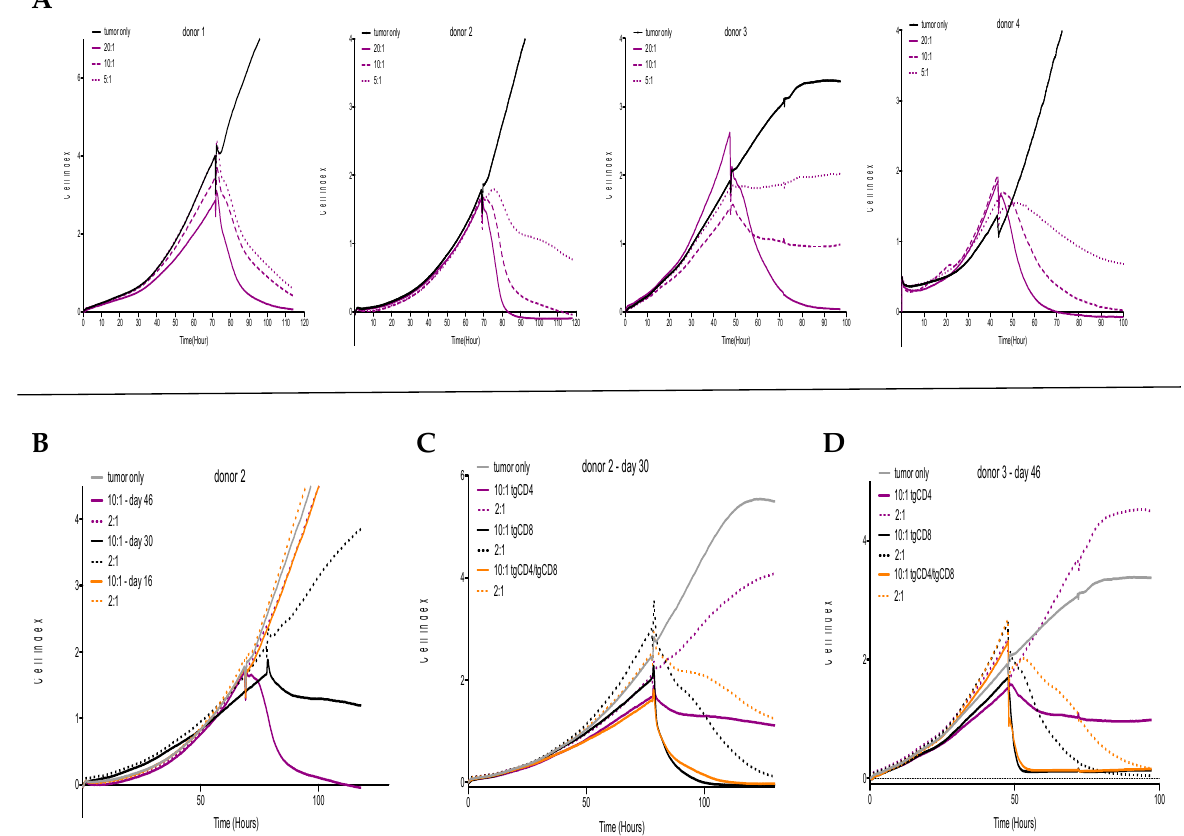
Figure 2. Donor- and time-dependent antitumor activity of STEAP1 130 / HLA-A*02:01-specific TCR transgenic CD4 + (tgCD4) T cells and CD8 + (tgCD8) T cells in vitro. ( A ) STEAP1 130 tgCD4 T cells show donor-dependent antitumor activity after 6 weeks of expansion and culture against A673 cells (4 donors). ( B ) Antitumor activity of tgCD4 T cells increased with the number of days in cell culture; assessed at day 16, 30, and 46 in effector-to-target ratios (E:T) 10:1 and 2:1. ( C,D ) Evaluation of antitumor activity of tgCD4, tgCD8, and tgCD4/tgCD8 (1:1) T cells at day 30 and day 46, indicating the superiority of tgCD8 T cells at all assessed points and E:T ratios (i.e. 10:1 and 2:1), respectively.